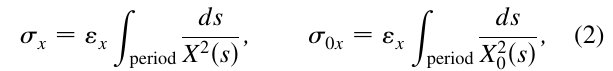
FIG. 1. (Color) Matching/injection section and first ring diag- nostics chambers (RC) in UMER. All focusing/bending ele- ments, including the injection dipole (D0) and quadrupoles, were DC operated at this stage of